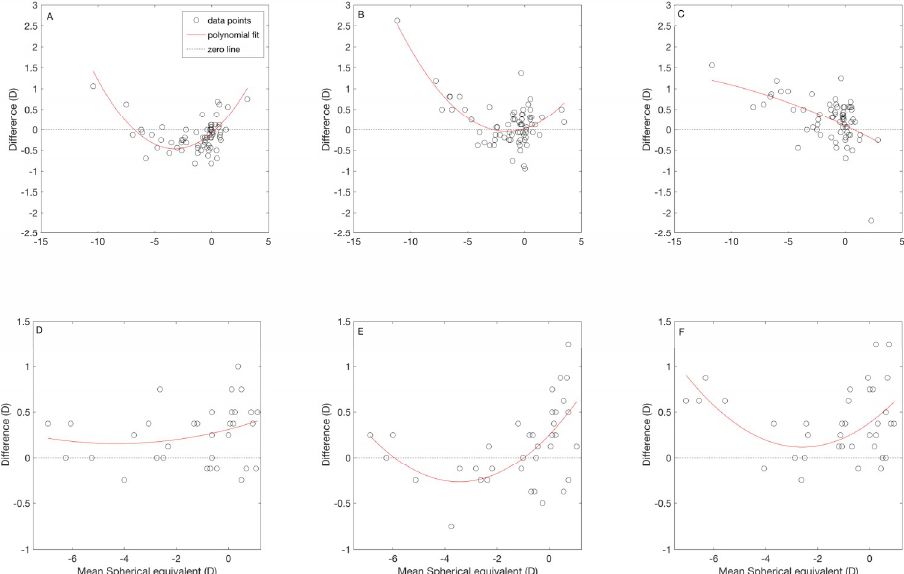
Figure 4. Relation between spherical equivalent and the mean di ff erence among di ff erent refractive methods. ( A – C ) Relation between the spherical equivalent and the mean di ff erence of each instrument. ( A ) Relation between the binocular instrument with fogging (B + F + ) and the binocular instrument without fogging (B + F − ); ( B ) relation between the B + F + and the monocular instrument with fogging (B − F + ); ( C ) relation between the B + F − and B − F + . ( D – F ): relation between spherical equivalent and the mean di ff erence for the comparison between the subjective refraction and the objective refraction measurement by each instrument. ( D ) relation between the subjective refraction (SR) and the B + F + ; ( E ) relation between the SR and B + F − ; ( F ) relation between the SR and B − F + . For all figures, the open circles denote the mean di ff erence and the red lines represent the quadratic polynomial curve fit.